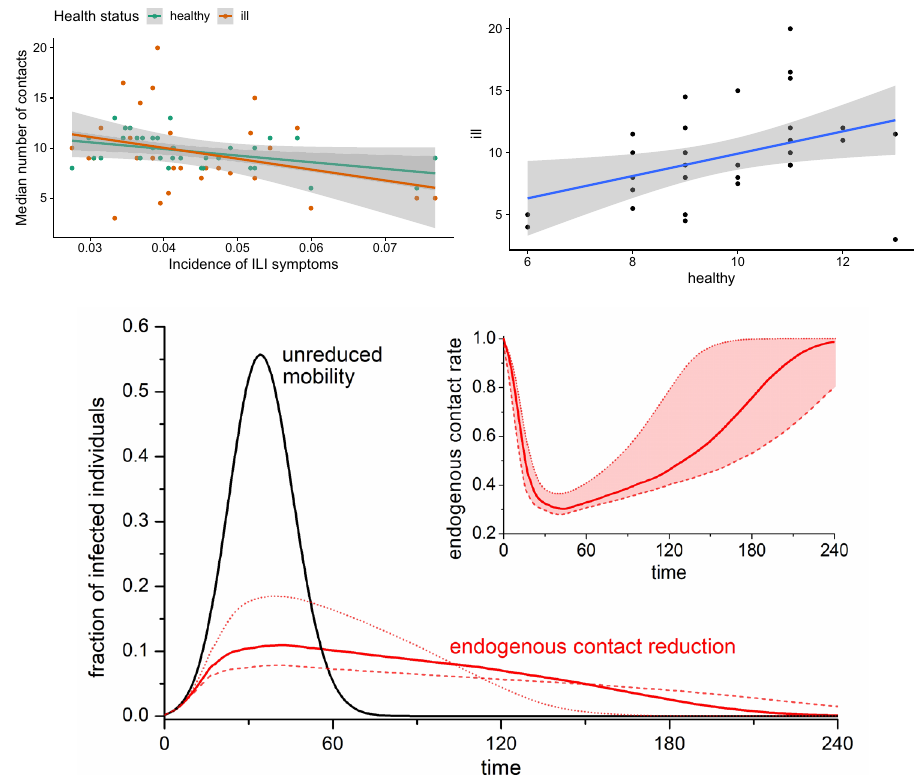
Figure 3. Social distancing for sick and healthy, and the effect on the epidemic curve. Top left: Median number of contacts in different weeks as a function of incidence of ILI symptoms among Flusurvey participants during that week. The lines show linear fits, and shades 95% confidence intervals. Slopes: healthy − 70 (95% CI − 120– (− 20)), ill − 110 (95 %CI − 220, 10); p value testing null hypothesis of slope 0: healthy 0.01, ill 0.07. Top right: Median number of contacts in participants with ILI symptoms as a function of the median number of contacts in participants without ILI symptoms. The line shows a linear fit, and shades 95% confidence intervals. Slope: 0.9 (95% CI 0.2–1.6); p value testing null hypothesis of slope 0: 0.02. Bottom: Comparison of the infected curves under unrestrained mobility (black) and endogenous contact reduction based on the Flusurvey data (black).